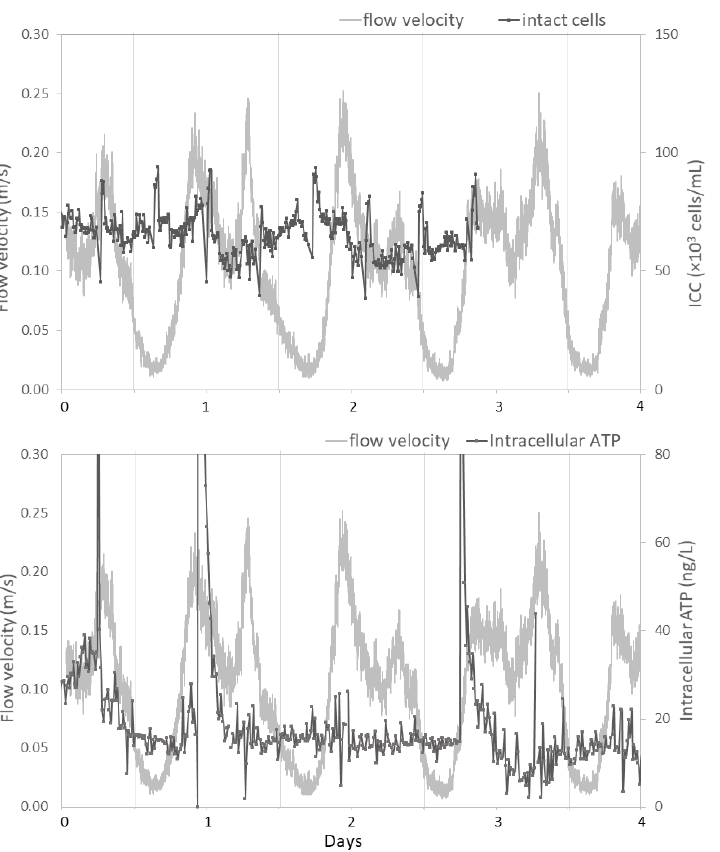
Figure 7. Variations over four days of flow velocity compared to FCM intact cells (ICC, top figure ) and intracellular ATP ( bottom figure ) at distribution location E. For comparison purposes, the flow velocity data shown on the top and bottom figure is identical. Flow velocity data is presented as moving averages. Vertical lines indicate the time at 0:00 of each day. Eight ATP data points up to 450 ng/L are out of